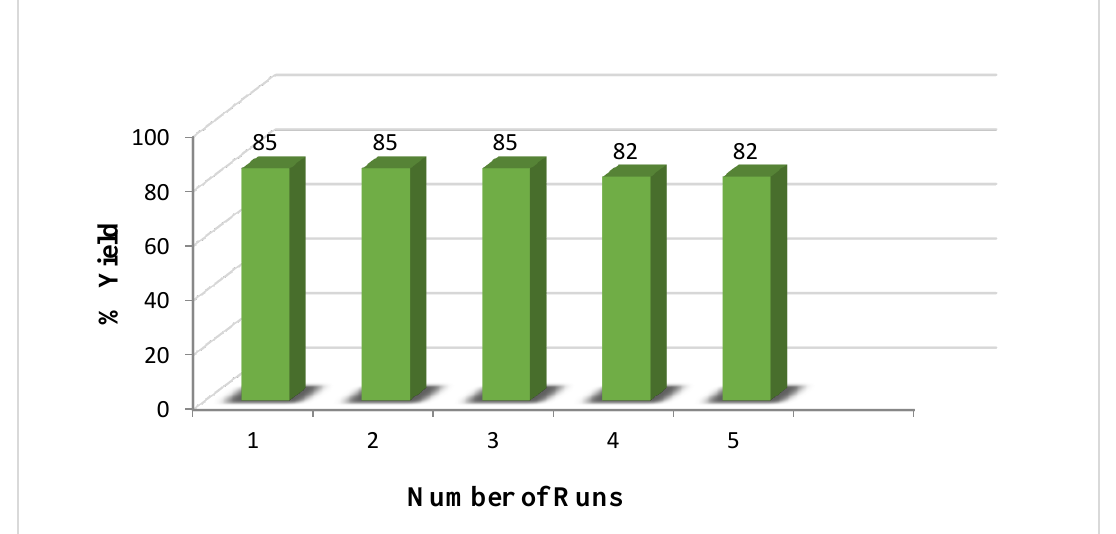
Figure 7. Re-usability of CoMgAl-LDH catalyst for formation of compound 3.